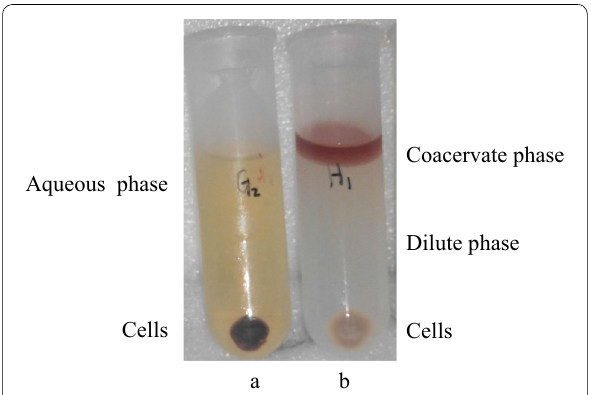
Fig. 1 The metabolites of phenanthrene in cells and CPS. a Control system; b CPS. The biodegradation of phenanthrene was carried out in 30 mL MSM in 150-mL shaking flask at 30 °C and 160 rpm for 5 days in control and CPS by S. polyaromaticivorans , respectively. Then, cells were harvested by centrifuge at 4 °C and 8000 rpm in the control ( a ) or CPS ( b ). The distribution of metabolite in both systems was shown in the figure